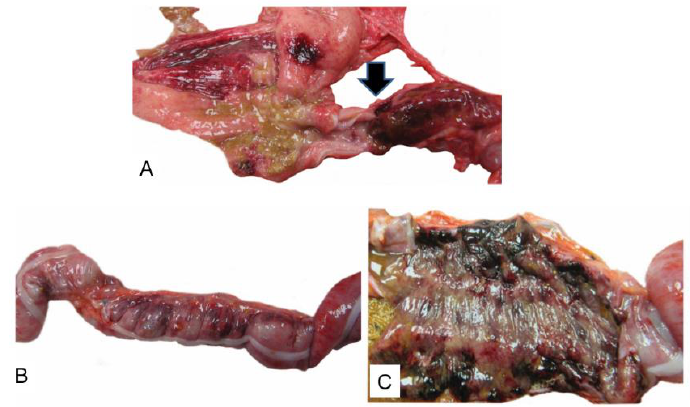
Figure 3. ( A – C ) Representative gross pathology images. ( A ) Stomach and duodenum, gross photo. There are multifocal hemorrhages of the gastric pyloric mucosa (left). Beginning distal to the pyloric sphincter, there is transmural hemorrhage and necrosis of the proximal duodenum likely due to infarction. ( B ) Colon, gross photo. Multifocal mural hemorrhages and congestion are visible from the external surface of the colon. ( C ) Colon, mucosa, gross photo. There are multifocal to coalescing areas of hemorrhage and necrosis visible in the colonic